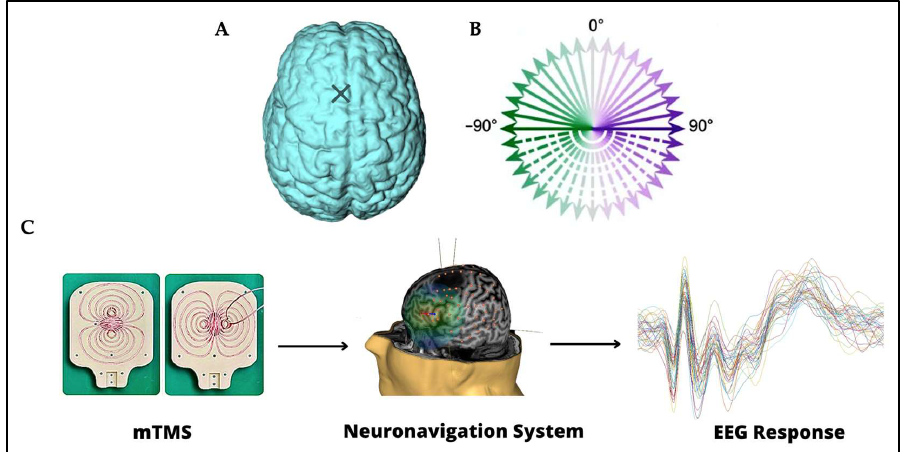
Figure 1. ( A ) The stimulation site on the left pre-SMA is indicated on the brain with a cross. ( B ) The 36 stimulation orientations are represented as green–purple vectors, 0° corresponds to stimulation delivered in the posterior–anterior direction, whereas −180° corresponds to stimulation delivered in the anterior–posterior direction [28]. ( C ) Instruments and techniques used. A 2-coil mTMS transducer, tracked with a neuronavigation system, was used in combination with a 64-channel EEG recording.